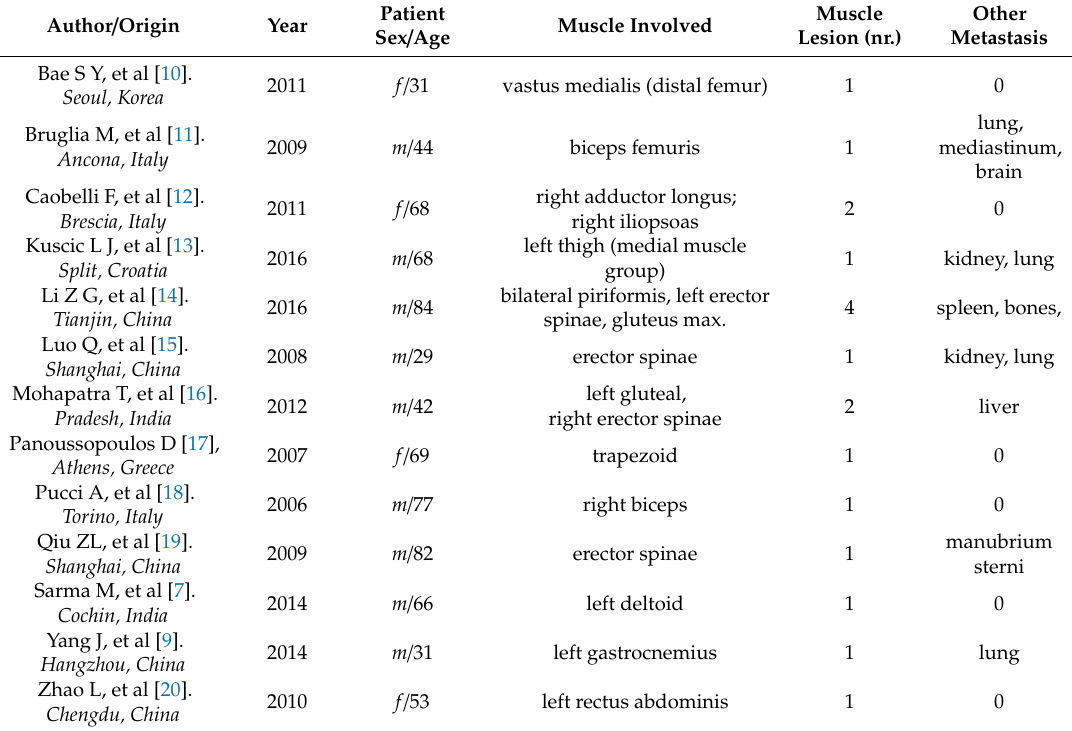
Table 1. Muscle metastases from PTC reported previously in